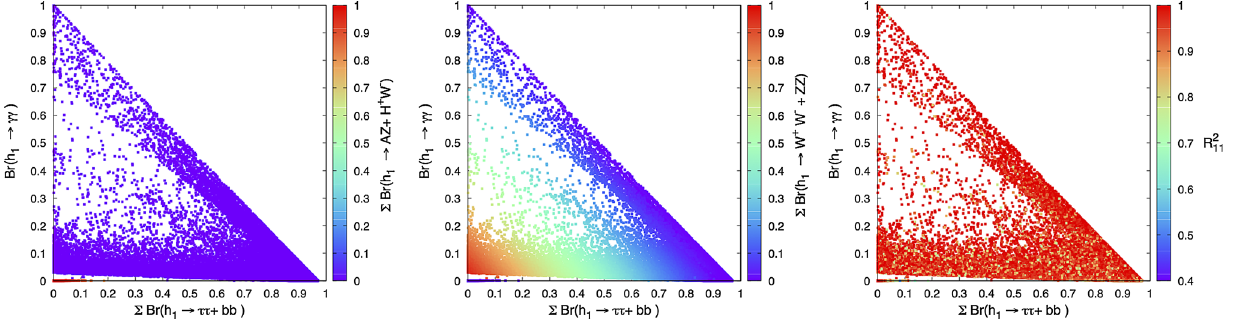
(right) at 95% . CL 1